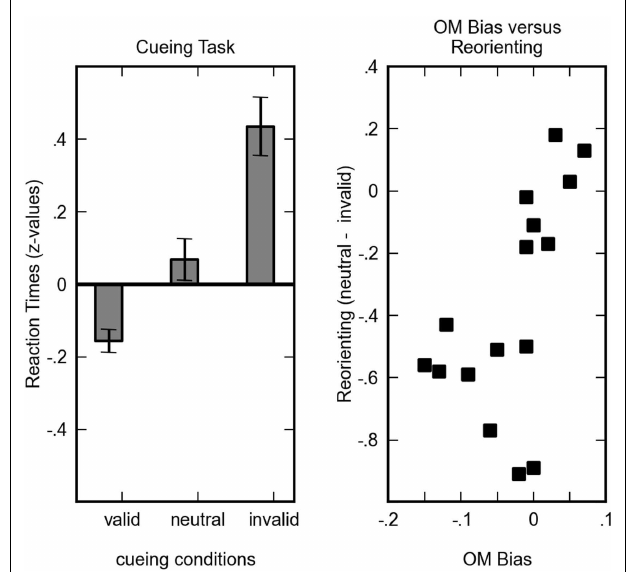
FIGURE 6 | Left column: z -standardized mean reaction times for valid, neutral and invalid conditions of the attention paradigm . Error bars indicate standard error of the mean. Right column: the reorienting effect (difference between neutral and invalid trials) plotted against the operational momentum bias. For reorienting better performance is indicated by numerically larger (i.e., less negative) values. A regular operational momentum effect corresponds to positive values, an inverse operational momentum effect corresponds to negative values.The correlation between reorienting and operational momentum signifies that the less children suffer from invalid cueing the more they are prone to exhibit a regular operational momentum